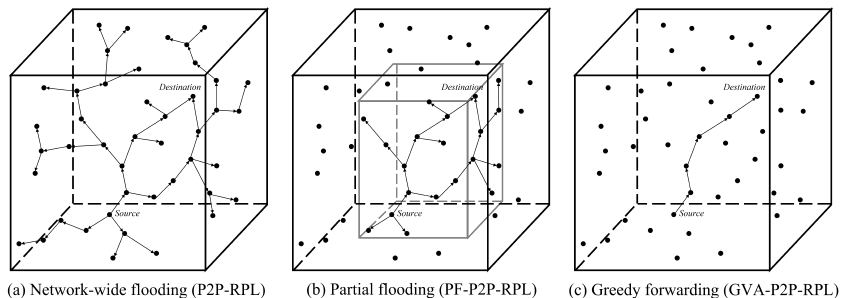
Figure 1. Routing strategies of P2P-RPL, PF-P2P-RPL and GVA-P2P-RPL. In ( a ), P2P-RPL floods P2P-DIO messages throughout the whole network. In ( b ), PF-P2P-RPL floods P2P-DIO messages only to the nodes in the restricted flooding zone, which is determined by the source and destination’s locations. In ( c ), GVA-P2P-RPL selects the closest neighbor node to the destination and forwards the P2P-DIO message to that neighbor